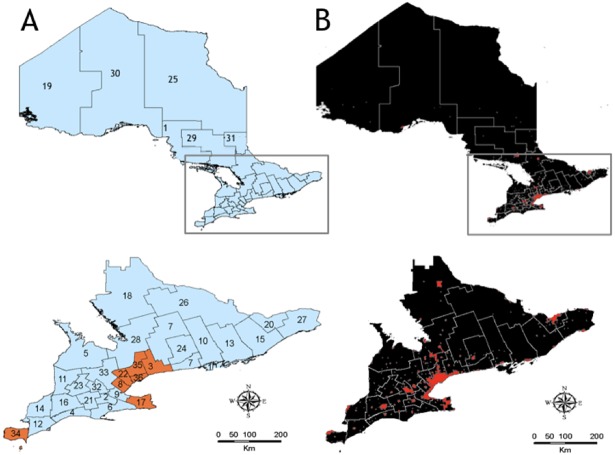
Map of the Ontario, Canada showing boundaries of municipal public health units and population density.(A) The 36 Ontario municipal public health units. Public health units we obtained weekly data from are highlighted in orange. 1-Algoma District; 2- Brant County; 3- DUR; 4- Elgin-St. Thomas; 5-Grey Bruce; 6- Haldimand-Norfolk; 7-Haliburton-Kawartha-Pine Ridge District; 8- HAL; 9-Hamilton; 10-Hastings and Prince Edward Counties; 11-Huron County; 12-Chatham-Kent; 13-Kingston-Frontenac and Lennox & Addington; 14-Lambton County; 15-Leeds-Grenville and Lanark District; 16-Middlesex-London; 17-NIA; 18-North Bay Parry Sound District; 19-Northwestern Region; 20-City of Ottawa; 21-Oxford County; 22-PEE; 23-Perth District; 24-Peterborough County-City; 25-Porcupine; 26-Renfrew County and District; 27- Eastern Ontario; 28 Simcoe Muskoka District; 29-Sudbury and District; 30-Thunder Bay District; 31-Timiskaming; 32-Waterloo Region; 33-Wellington-Dufferin-Guelph; 34-WEC; 35-YRK; 36- TOR. (B) Population centers are shown in red. Maps were created in Arc Map 10.4.